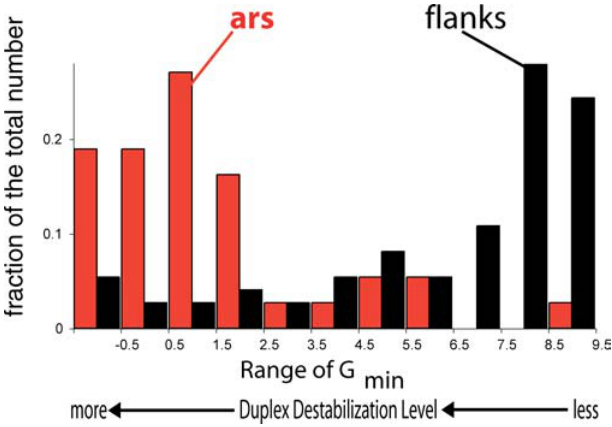
Figure 4. Duplex Destabilization at ARS Elements Compared with Duplex Destabilization at the Surrounding Sequences This histogram shows the distributions of ARS elements (red), and of comparison regions (black) whose G min values fall in the indicated ranges. (Here, as elsewhere, the lower the G min value, the more destabilized the region.) The comparison regions were chosen to have the same lengths as the ARS element they flank, and to be positioned 250 bp away from it on either side. There being twice as many comparison regions as ARS elements, these distributions are normalized to show the fraction of sites of each type falling within each interval. Equivalent results were obtained when the comparison regions were chosen to directly abut the ARS elements, so the localization of destabilization at ARS elements is not simply a consequence of their positions within intergenic regions. (ARS elements 302, 303, and 320 on Chromosome III were positioned very close [20 bp separate ARS302 from ARS303, and ARS320 directly abuts ARS303], so for the purpose of these statistical tests these three were regarded as a single site.) DOI: 10.1371/journal.pcbi.0010007.004